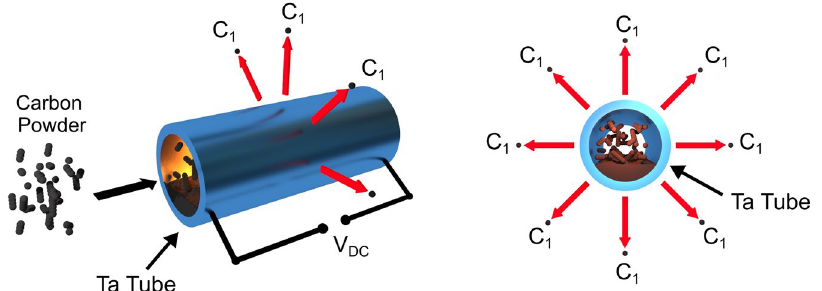
Figure 1. Schematic diagram of the novel atomic carbon source. Carbon powder is sealed into a thin-walled Ta tube, which is subsequently heated by a DC